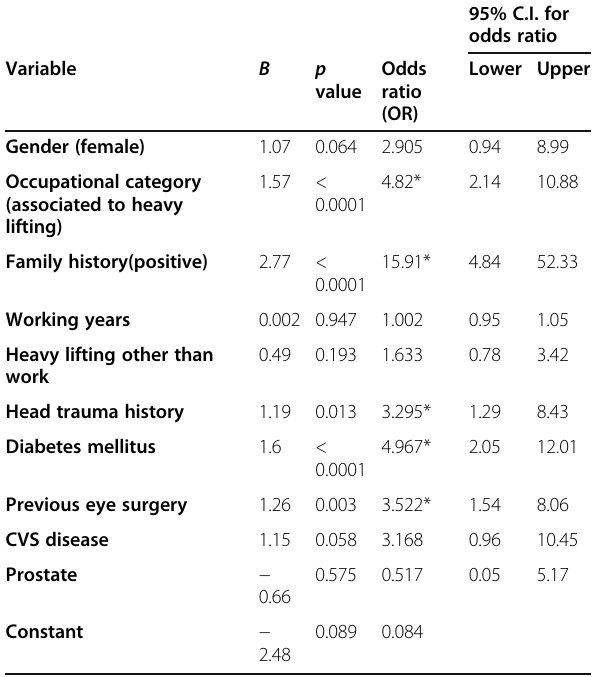
Table 5 Multivariate logistic regression of studied risk factors of RD